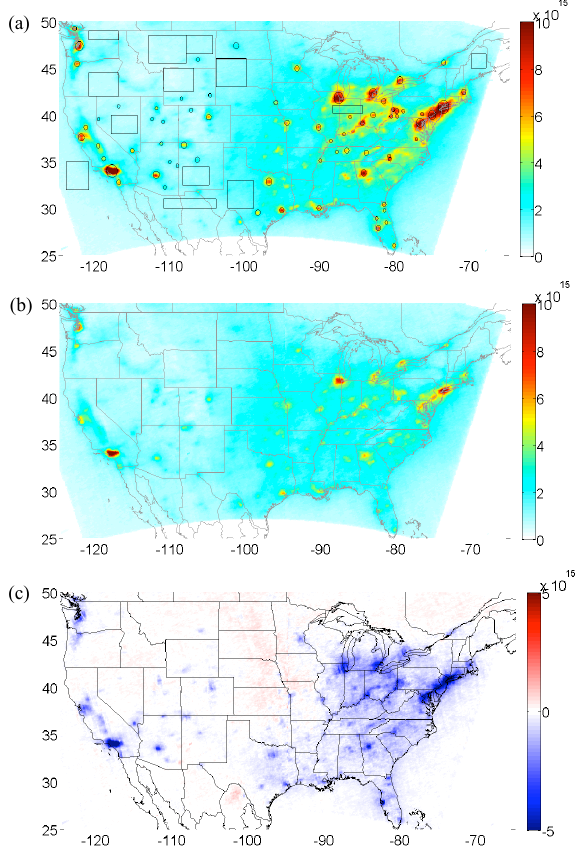
Fig. 1. Average summertime (April–September) OMI BEHR NO 2 column densities (moleculescm − 2 ) for (a) 2005, (b) 2011, and (c) the difference,